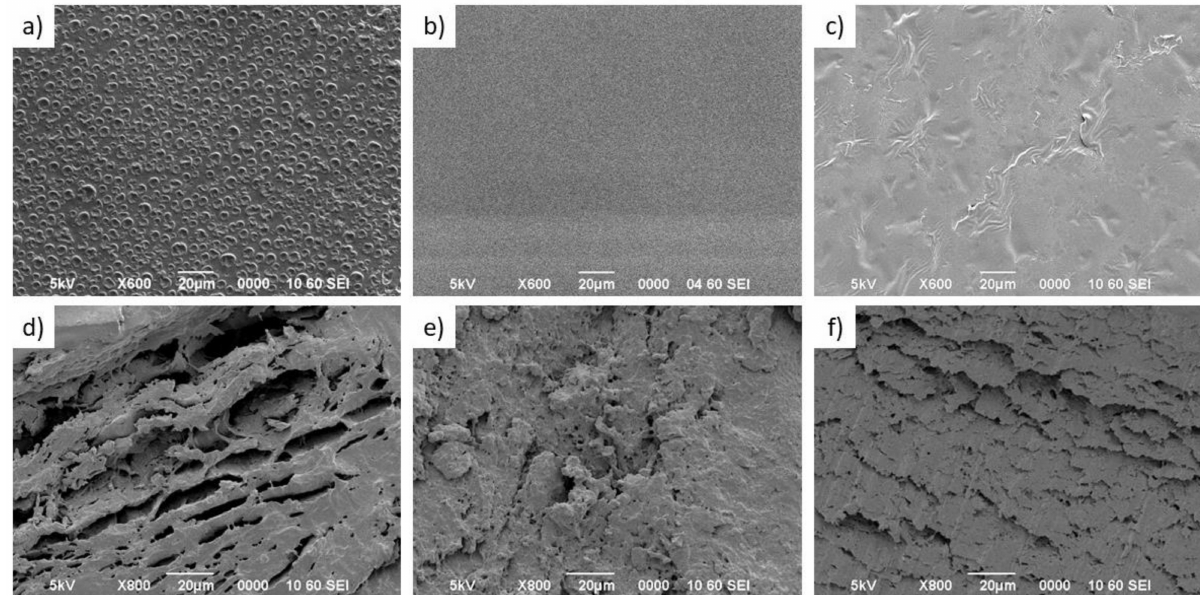
Figure 4. SEM micrographs of the surface ( a – c ) and cross sections ( d – f ) of three formulated scaffolds (scale bar: 20 µ m); ( a , d ) F1 scaffold, ( b , e ) F2 scaffold, and ( c , f ) F3 scaffold.